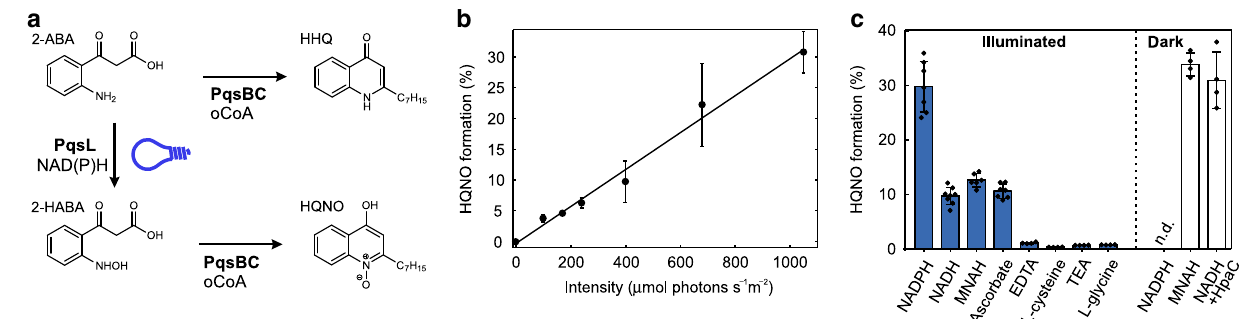
Fig. 1 Blue-light-induced activity of PqsL. a Reaction of PqsL within the alkyl quinolone biosynthetic pathway. The downstream/parallel reaction of PqsBC was used throughout the study for coupled assays to quantify PqsL catalytic activity. 2-HABA is unstable with a t ½ of 16 minutes. 2-ABA — 2- aminobenzoylacetate; HHQ — 2-heptyl-4(1 H )-quinolone; 2-HABA — 2-hydroxylaminobenzoylacetate; HQNO — 2-heptyl-4-hydroxyquinoline- N -oxide; oCoA — octanoyl-CoA. b HQNO formation in the coupled enzyme assay as a function of light intensity (LED source, ʎ max 466 nm, 20 nm full width at half maximum, n ≥ 6). c HQNO formation in the coupled enzyme assay depending on the PqsL electron donor ( n ≥ 4). The fl avin reductase HpaC was used to generate reduced fl avin in situ for PqsL light-independent activity with NADH. Error bars denote SD of independent experiments. MNAH — 1-methyl-1,4- dihydronicotinamide, TEA